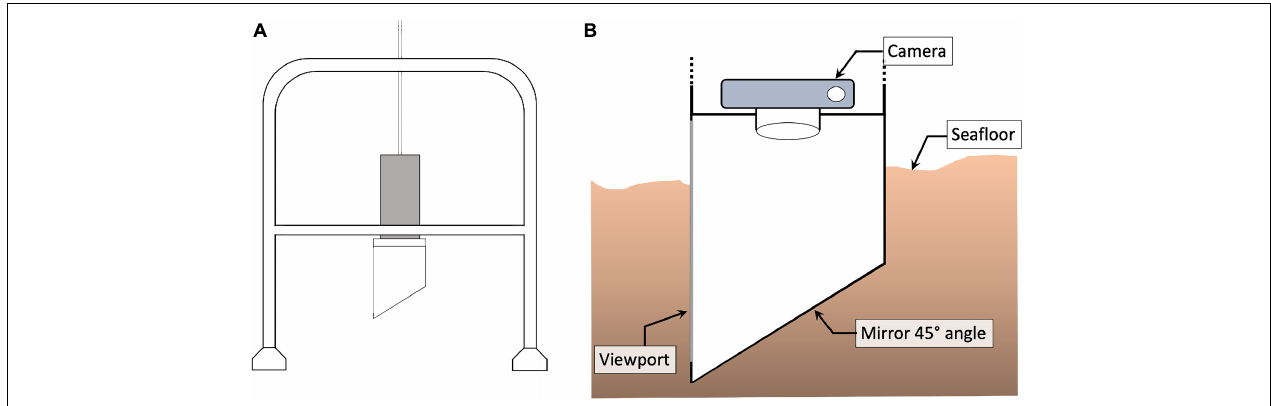
FIGURE 1 | (A) Schematic of the SPI camera lander system. (B) Close up view of a SPI camera inserted into the sediment at the seafloor with a downward-looking camera, 45-angled mirror and viewport allowing to see the water-sediment interface.